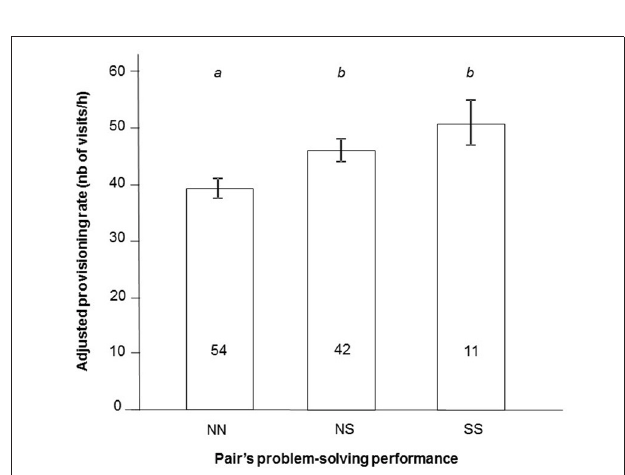
FIGURE 2 | Pair’s provisioning rates (least square means ± SE) according to its problem-solving performance (NN, pairs where both parents were non-solvers; NS, pairs with one solver; SS, pairs with two solvers) in a natural population of great tits. Values are adjusted for the other significant effects of the model, i.e., effects of brood size treatment and year. Letters represent results of Tukey HSD test, where different letters are attributed to significantly different groups. Numbers are sample